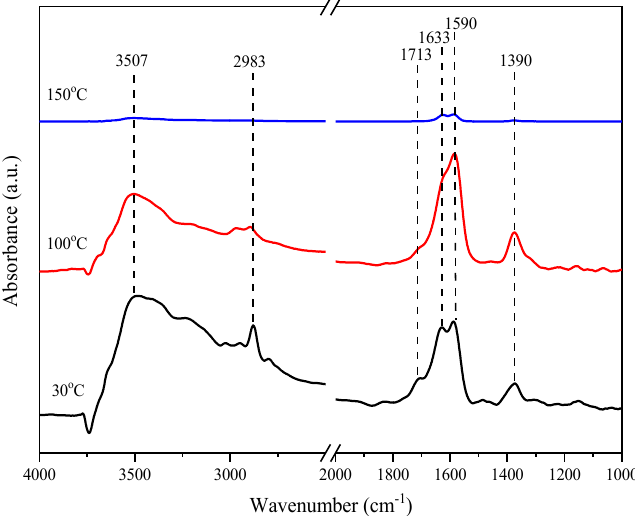
Figure 10. In situ DRIFTS spectra of the Eu / NaSep sample after 1 h of HCHO oxidation at 30, 100, and 150 ◦ C.